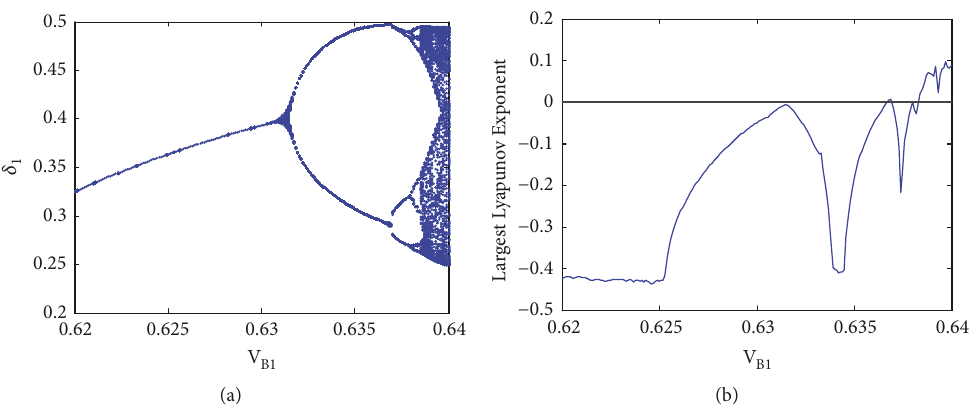
Figure 2: (a) Bifurcation diagram. (b) Largest Lyapunov exponent